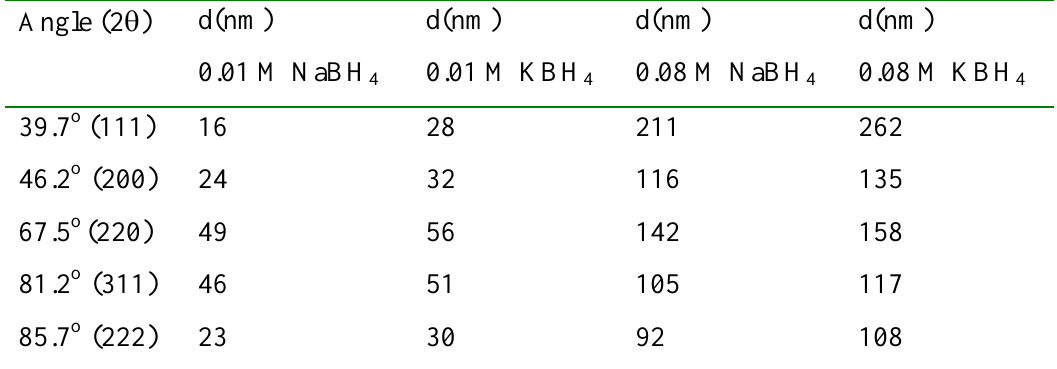
) Cl of 0.01 M concentration and two different reductant 3 4 2